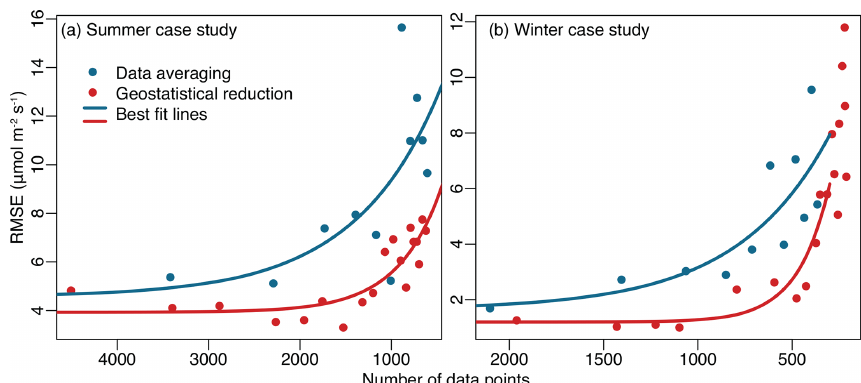
Figure 5. Root mean squared error (RMSE) of the fluxes estimated using data reduction relative to the fluxes estimated without data reduction. The figure displays results for the summer (a) and winter (b) case studies. Fluxes estimated using the data reduction approach proposed here have a lower RMSE relative to those estimated using the binning and averaging approach to data reduction.